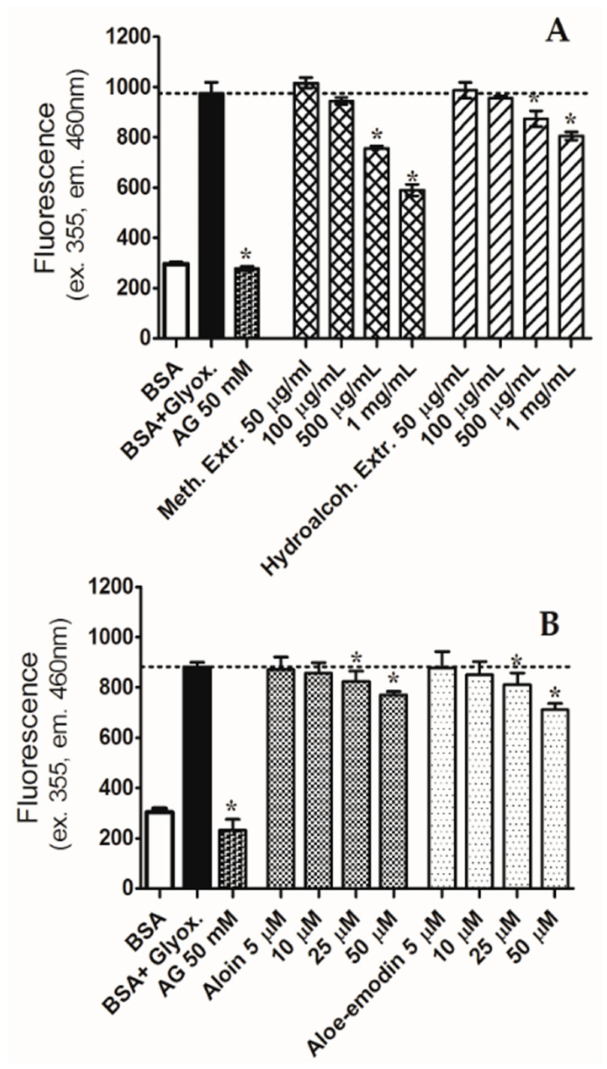
Figure 2. E ff ects of the methanolic (Meth.) and hydroalcoholic (Hydroalcoh.) A. arborescens extracts ( A ), and aloin and aloe-emodin ( B ) against bovine serum albumin (BSA) glycation after seven days of incubation with glyoxal (Glyox.) 0.4 mg / mL. Aminoguanidine (AG) was used as positive control. Extr: extract. * p < 0.05 vs. BSA plus